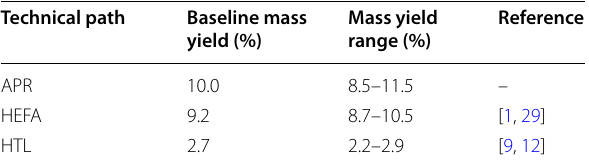
Table 4 The mass yield range of bio-jet fuel Technical path